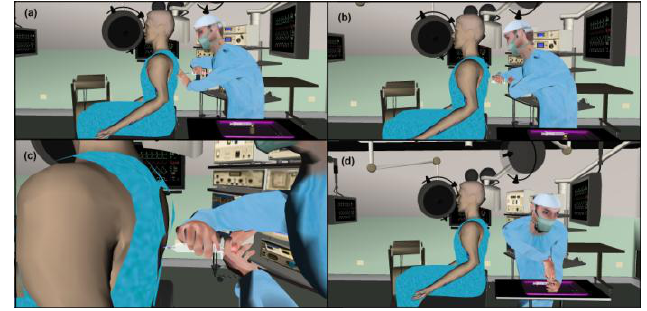
Fig. 6. Virtual medic carrying out the pleural tap procedure: (a) needle insertion; (b) aspiring the pleural liquid; (c) detail of the aspiration of liquid; (d) draining the syringe content in a container.